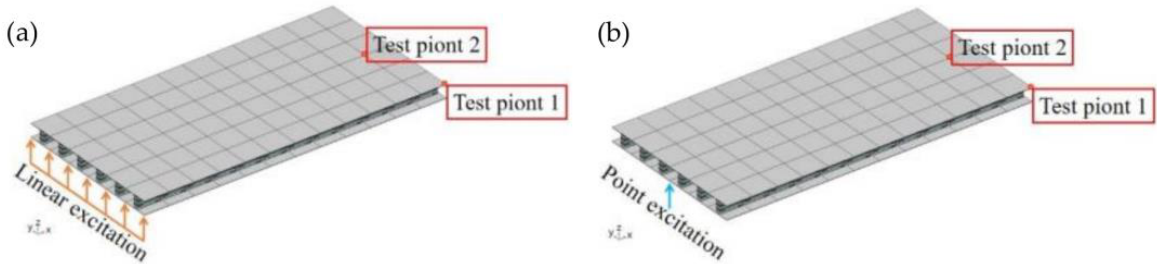
Figure 13. Schematic diagram of a phononic crystal sandwich plate structure applied to vibration control of the ship’s power system bulkhead. ( a ) Under a linear excitation. ( b ) Under a point excitation.